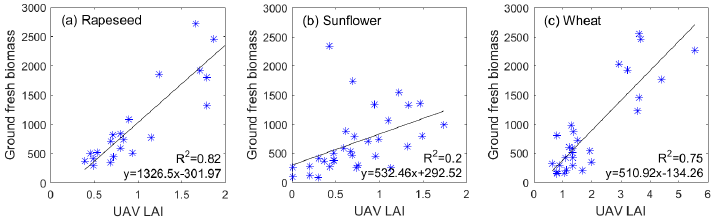
Figure 7. Regression between UAV estimated LAI from the uniform dense LUT and ground measured biomass quantity (g/m 2 ). * represents the scatter points.